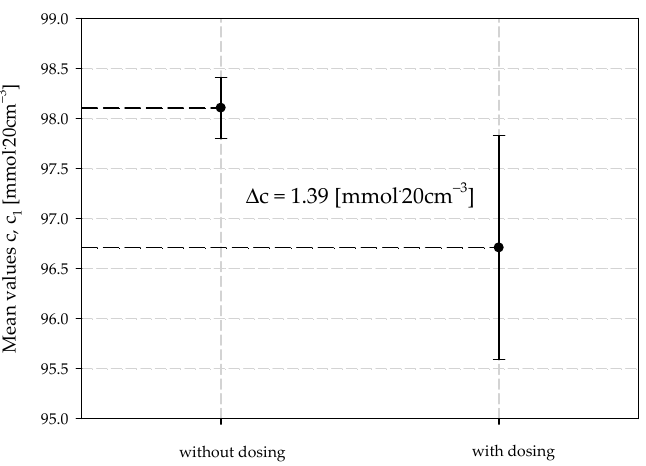
Figure 11. Chlorides concentration values with and without dosing AAB to B10.